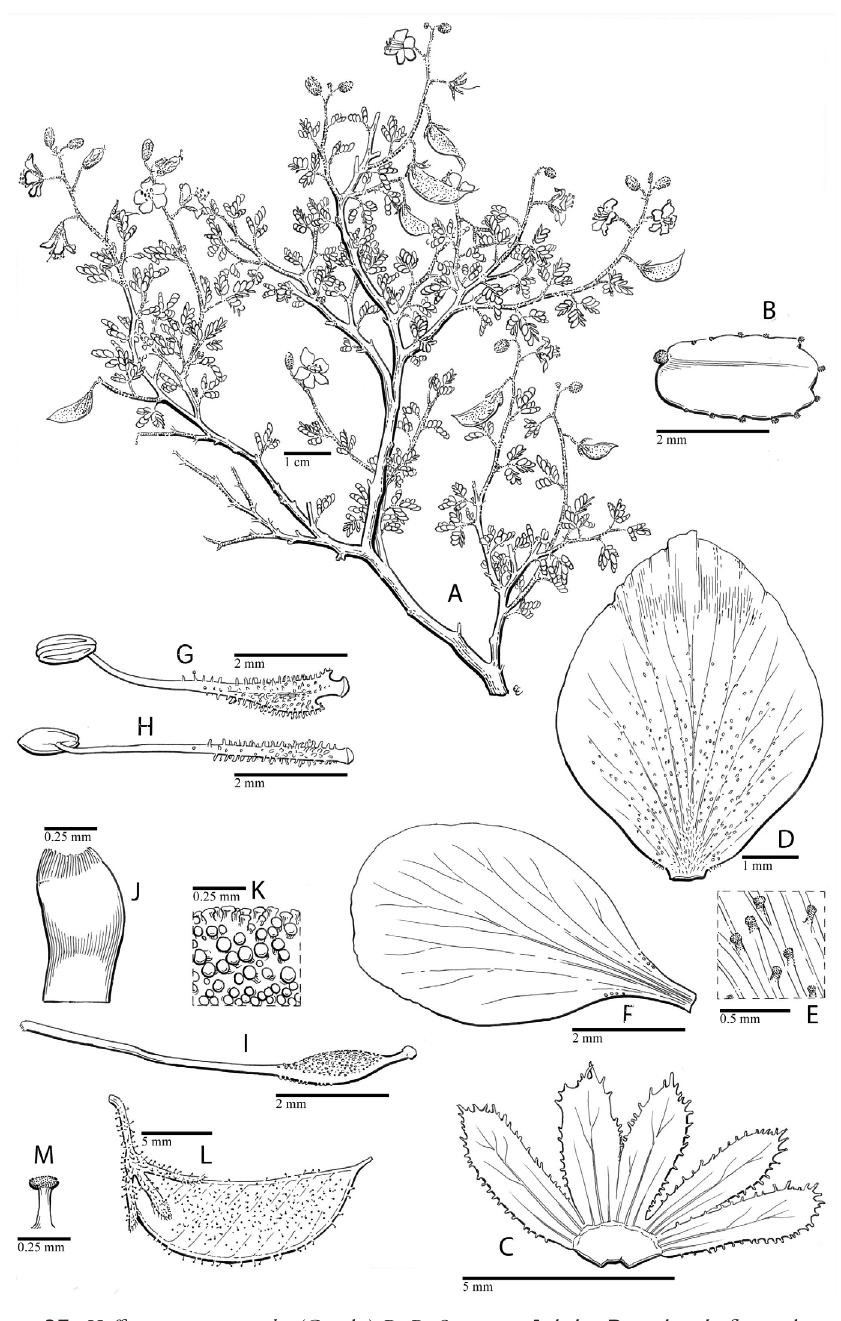
Figure 37. Hoffmannseggia pumilio (Griseb . ) B. B. Simpson. A habit B median leaflet undersurface C calyx opened out D median petal E detail of glands on dorsal surface of median petal F lateral petal G, H stamens I gynoecium J stigma K detail of glands on ovary L fruit M gland on fruit. A, L–M from Cabrera 30150 B–K from Venturi 8309. Drawn by Eleanor